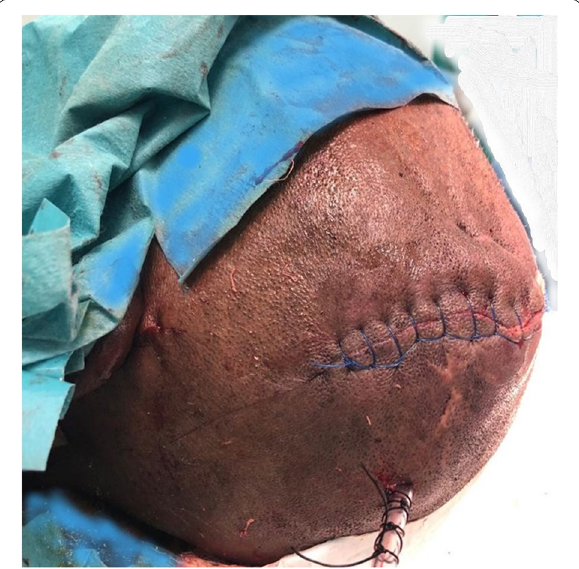
Fig. 6 Scalp incision is closed after pneumatocele